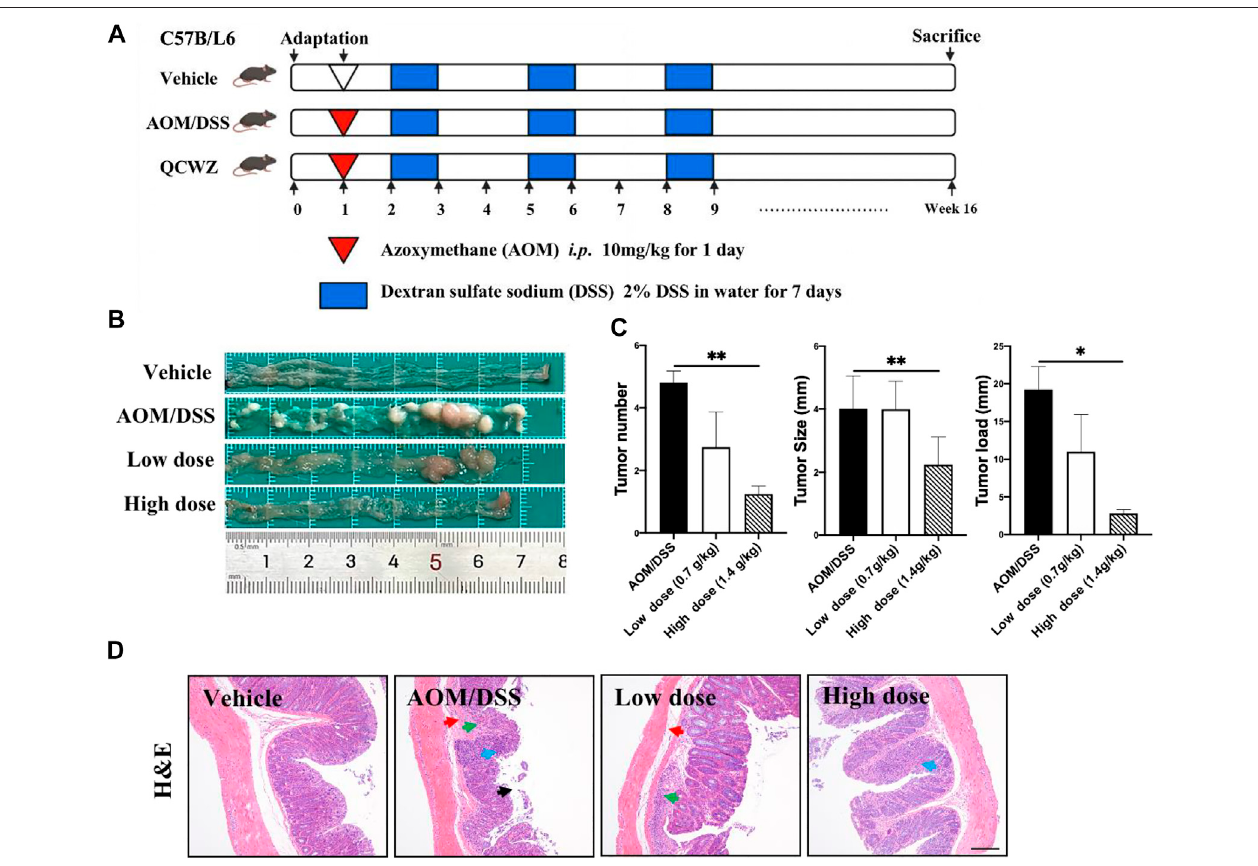
FIGURE 1 | Preventive effect of QCWZD on AOM/DSS-induced colon cancer in C57BL/6 mice. (A) AOM/DSS-induced animal model in C57B/L6 mice . (B) Colon morphology . (C) Measured tumor number, size, and load. (D) Representative H&E-stained colorectum sections (magni fi cation: ×200). Black arrow: local necrosis and abcissionofintestinalmucosalepithelialcells,bluearrow:focalin fi ltrationofin fl ammatorycellsinthemucosallayer,greenarrow: fi broustissuehyperplasiainthemucosal layer and disappearance of some intestinal glands, red arrow: fi brous connective tissue hyperplasia and increased tissue space in the submucosa; low dose: 0.7 g/kg, high dose: 1.4 g/kg; * p < 0.05, ** p < 0.01.